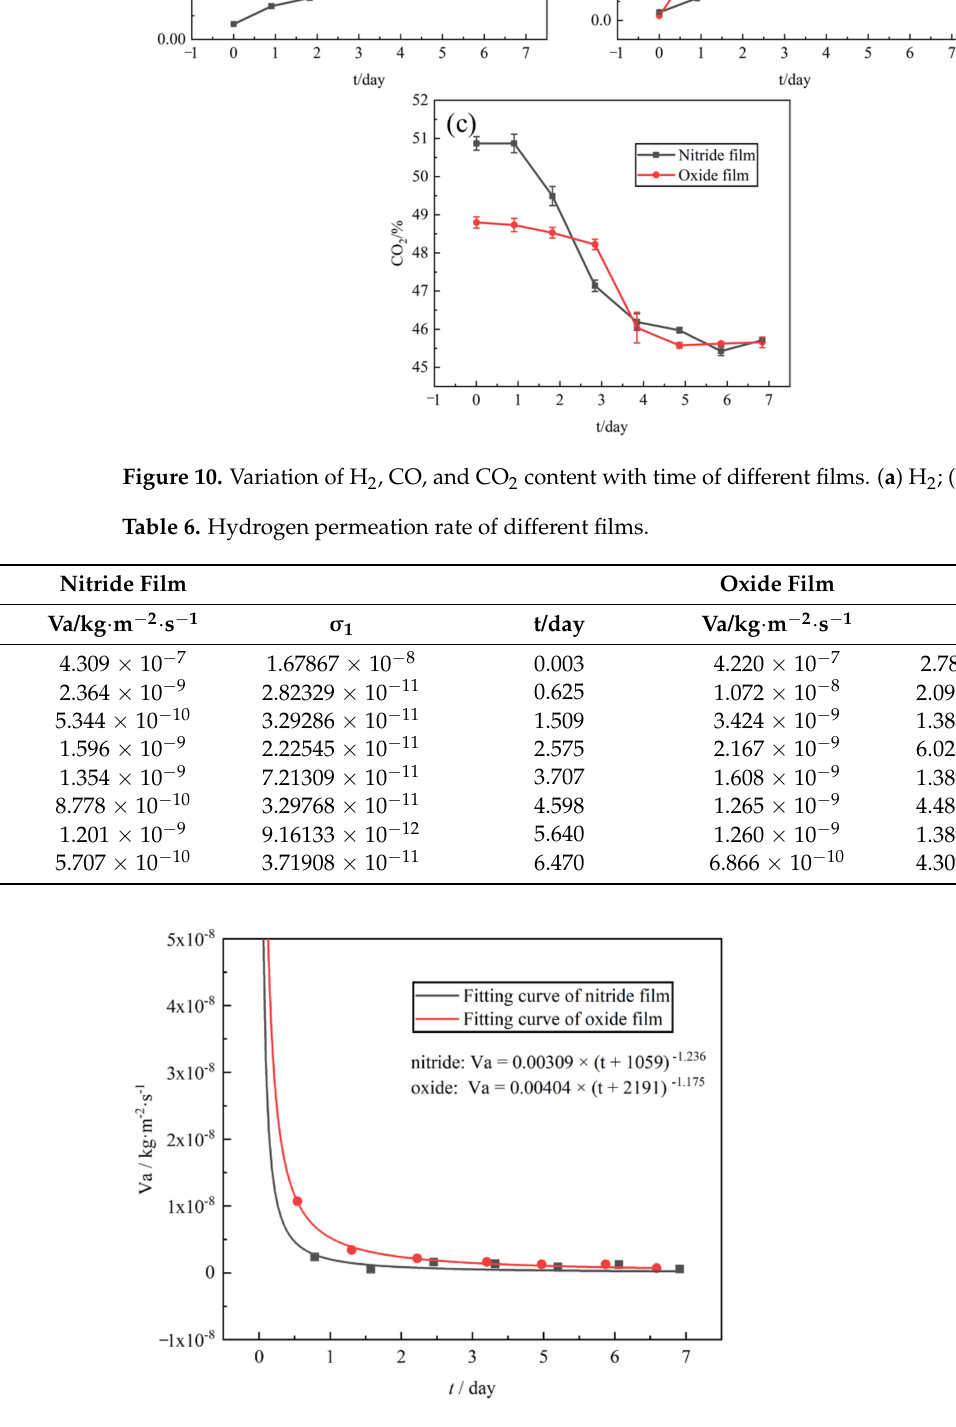
Figure 11. Fitting diagram of hydrogen permeation rate of different